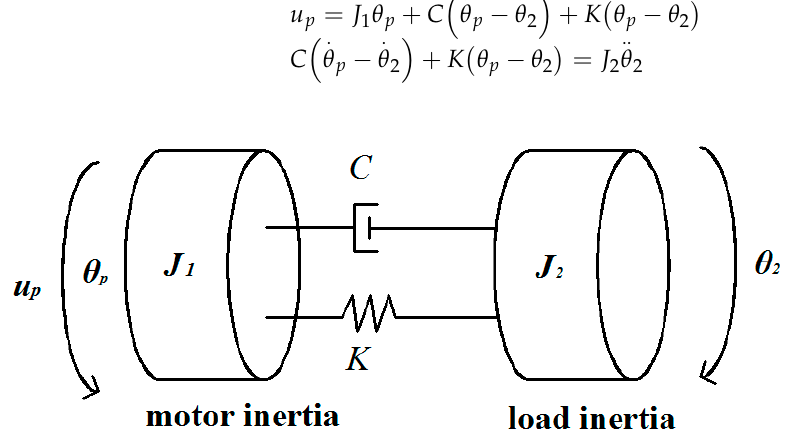
Figure 4. Two-inertia model.